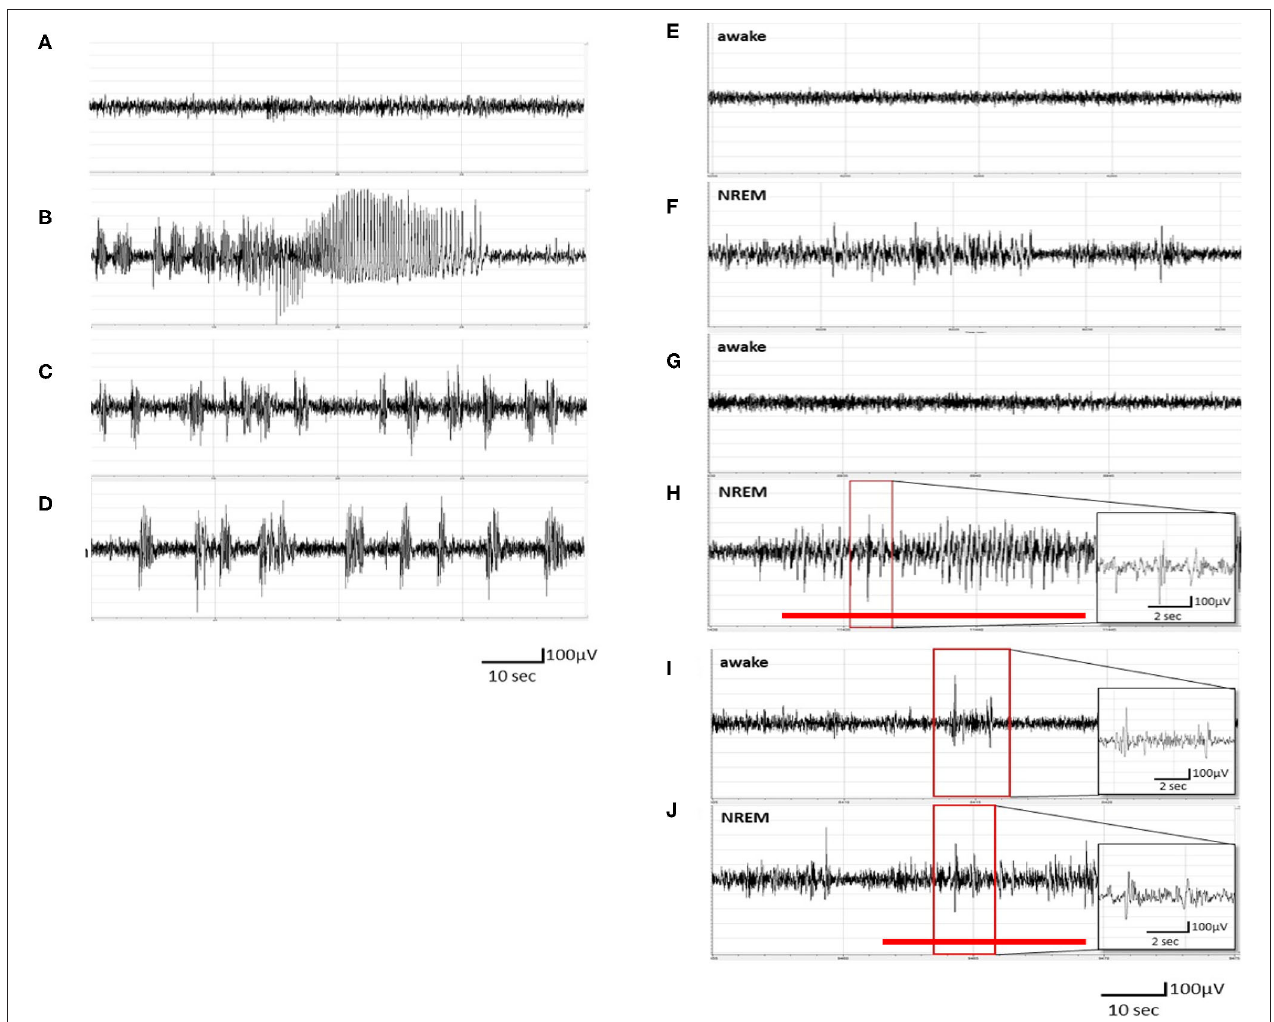
FIGURE 1 | Pentylenetetrazol (PTZ) kindling-induced ictal epileptiform electroencephalogram (EEG) and spontaneous recurrence of epileptiform EEGs. (A) The EEGs obtained after the vehicle (pyrogen-free solution) injection. (B) The ictal epileptiform EEGs obtained after the 1st PTZ injection. (C) The ictal epileptiform EEGs obtained after the 7th PTZ injection. (D) The ictal epileptiform EEGs acquired after the 14th PTZ injection. (E,F) The EEGs obtained 6h after the 1st PTZ injection during wakefulness and NREM sleep, respectively. (G,H) The EEGs obtained 6h after the 7th PTZ injection during wakefulness and NREM sleep, respectively. (I,J) The EEGs obtained 6h after the 14th PTZ injection during wakefulness and NREM sleep, respectively. The red line depicts the duration for spontaneous recurrence of epileptiform